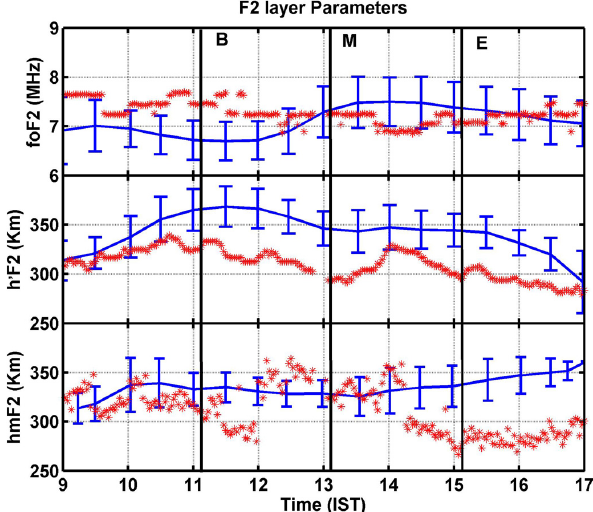
Fig. 5. Top, middle and bottom panels show temporal variations of the comparison of fo F2, h 0 F2 and hm F2 from the control days. The blue lines with error bar represent the mean values for the control days. Red stars correspond to the observations of eclipse